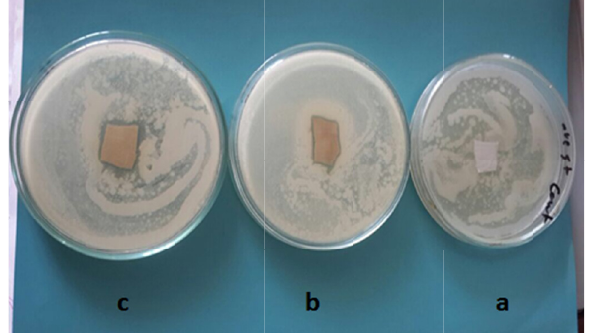
Fig. 7. Antibacterial effects of the untreated and AgNPs-treated silk fabrics on E.coli (A) Gram-negative bacteria.